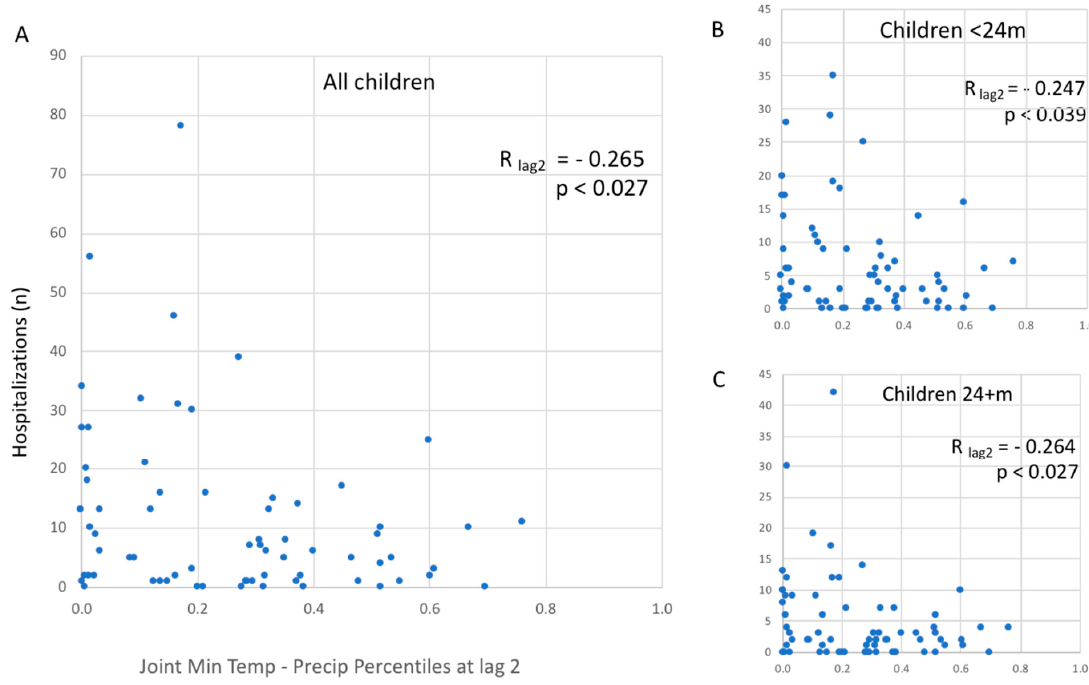
Figure 4. Scatter plots illustrating relationships between monthly rotavirus gastroenteritis hospital admissions and the joint percentiles for mean minimum temperature and precipitation at the lag of two months for all hospital admissions ( A ), for hospital admissions of children less than 24 months of age ( B ), and for hospital admissions for children 24 months and older ( C ).